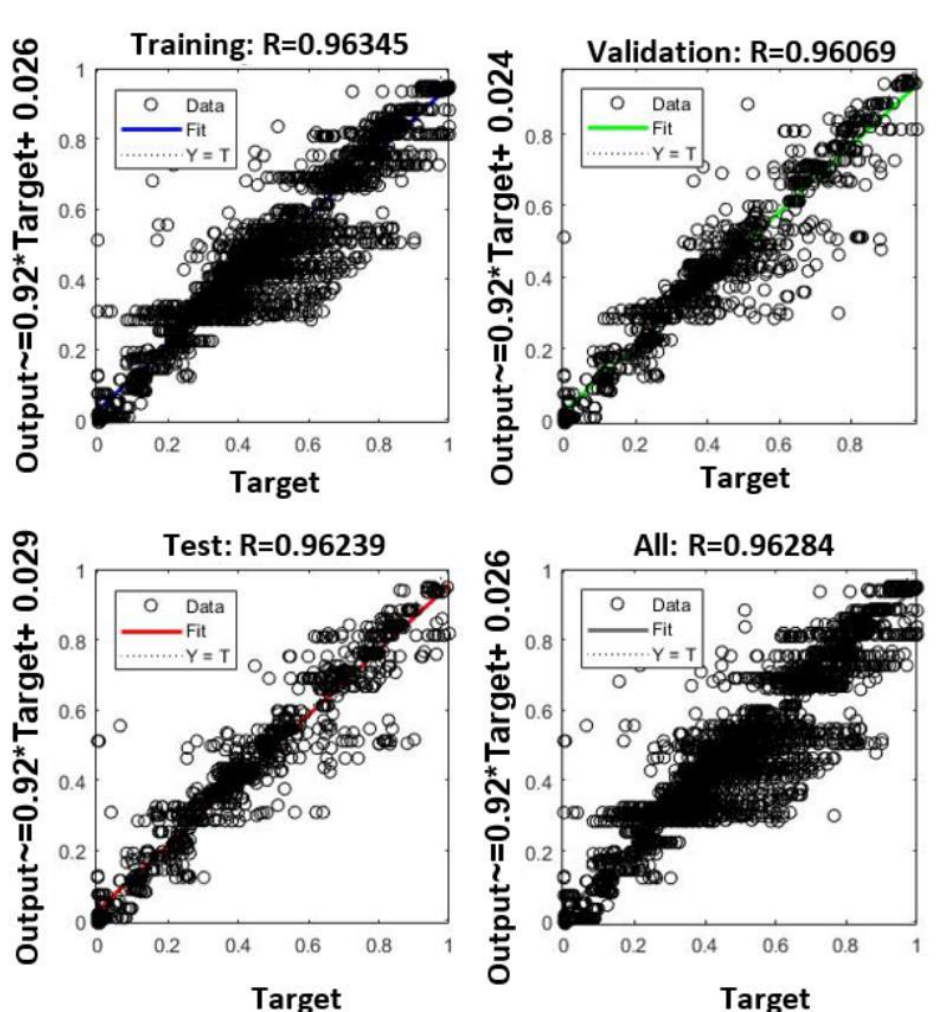
Figure 10. R values of training, validation and test data.